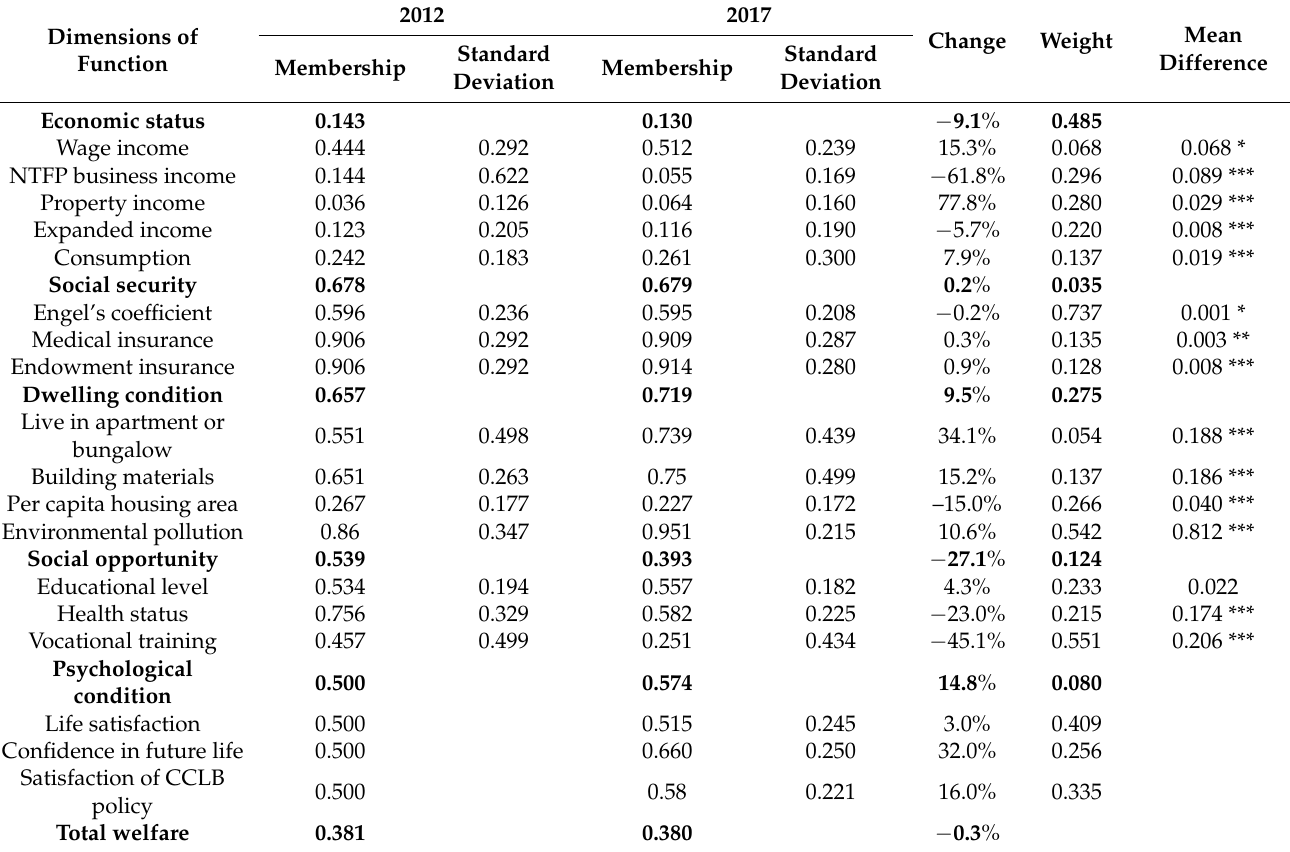
Table 3. Changes in welfare functions before and after logging